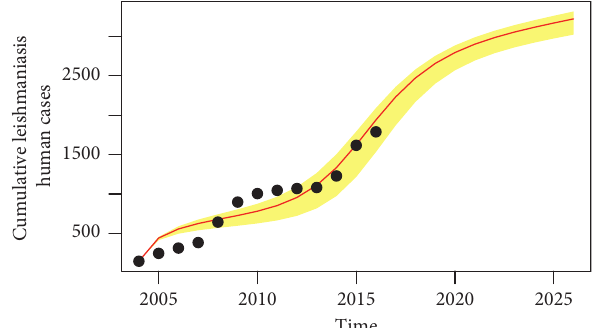
Figure 4: Prediction of cumulative incidence in 10 years from 2016 to